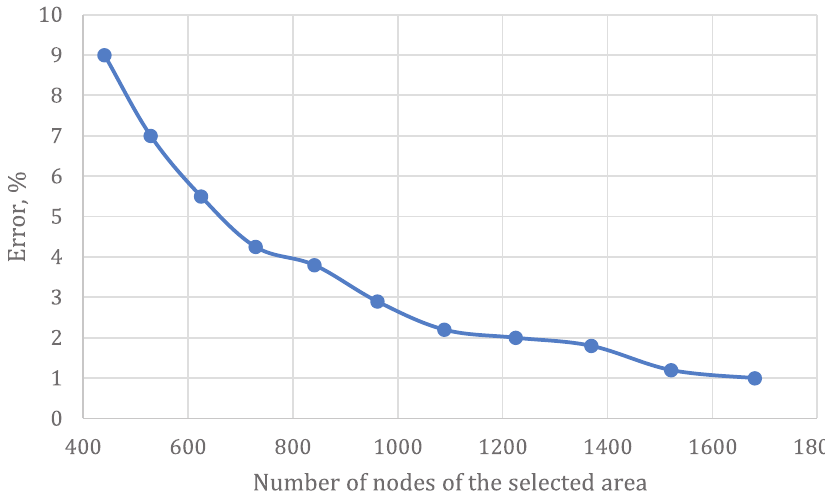
Figure 7. The decrease in the error with an increase in the number of nodes in the